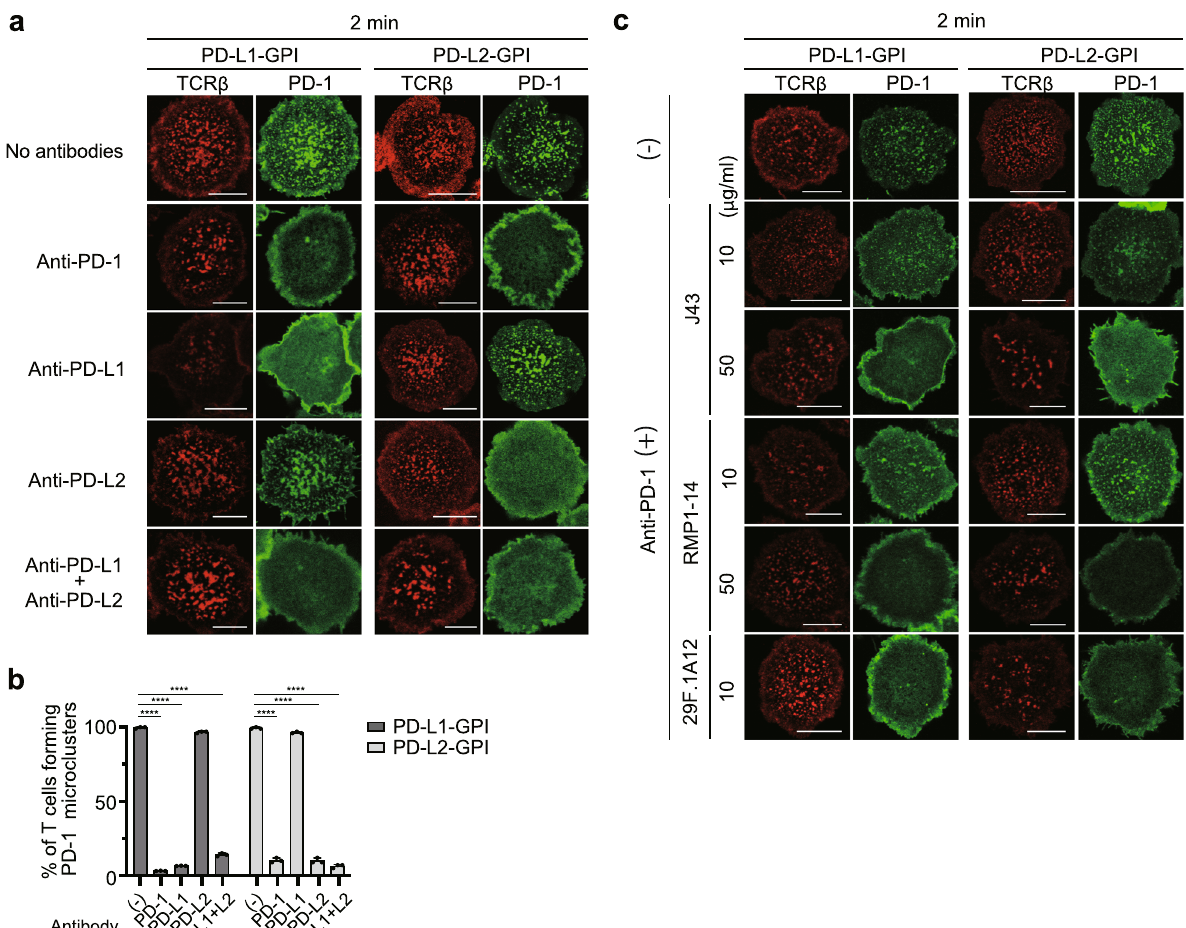
Fig. 2 Each blocking antibody for PD-1, PD-L1, or PD-L2 requires its own concentration to block PD-1 microcluster formation. a 2D12 expressing mPD- 1 – EGFP (green) cells were prestained with DyLight 650 – labeled H57 Fab (red) and plated on an SLB with mPD-L1 – GPI (left two columns) or mPD-L2 – GPI (right two columns) as in Fig. 1a. The cells were real-time imaged by confocal microscopy at 2 min after contact in the absence (top) or presence of anti- PD-1 (29F.1A12, row 2), anti-PD-L1 (MIH5, row 3), anti-PD-L2 (MIH37, row 4) or both anti-PD-L1 and anti-PD-L2 (bottom). b The graph shows the percentage of T cells forming PD-1 microclusters in a ( n = 30). c 2D12 expressing mPD-1 – EGFP were imaged as in a in the absence (top) or presence of three different anti-PD-1 mAbs, J43 (row 2 and 3), RMP1-14 (row 4 and 5) or 29 F.1A12 (bottom) at a concentration of 10 or 50 μ g/ml. All data are representatives of three independent experiments. Bars, 5 μ m. Error bars, SD. Statistical analysis was by one-way analysis of variance (ANOVA). **** p <